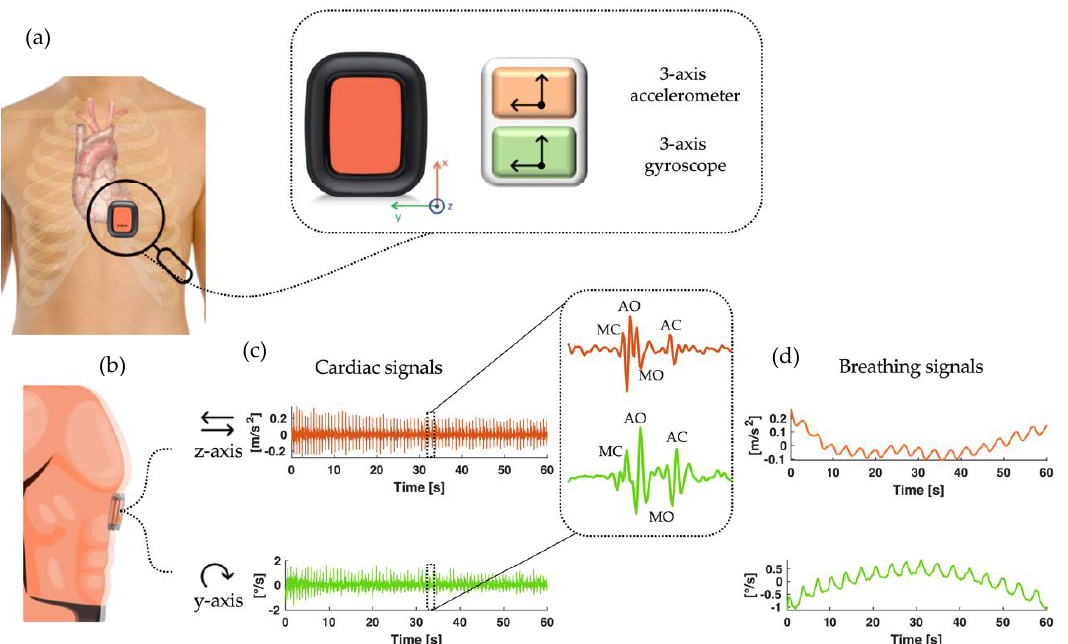
Figure 1. ( a ) Schematic illustration of the positioning of the IMU sensor (embedding the ACC and the GYR) on the subject’s chest from the frontal view. ( b ) Lateral view of the IMU sensor on the subject’s chest. Note that the sensor is integral with the body of the subject. This ensures that acceleration and angular velocity measurements correspond with good approximation to those experienced by the chest in response to cardiac and respiratory activity. ( c ) Example of an acceleration (in orange) and angular velocity (in green) signal filtered so that only the cardiac component is reported. ( d ) Example of an acceleration (in orange) and angular velocity (in green) signal filtered so that only the respiratory component is reported.